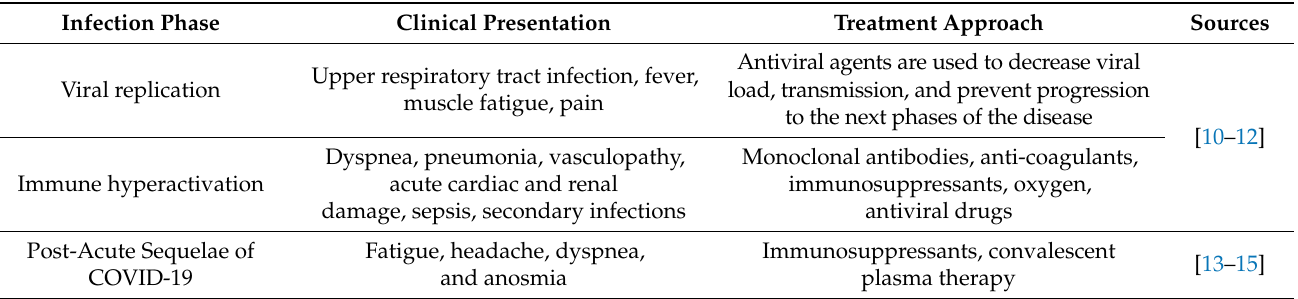
Table 1. Phases of COVID-19 infection and the corresponding treatment